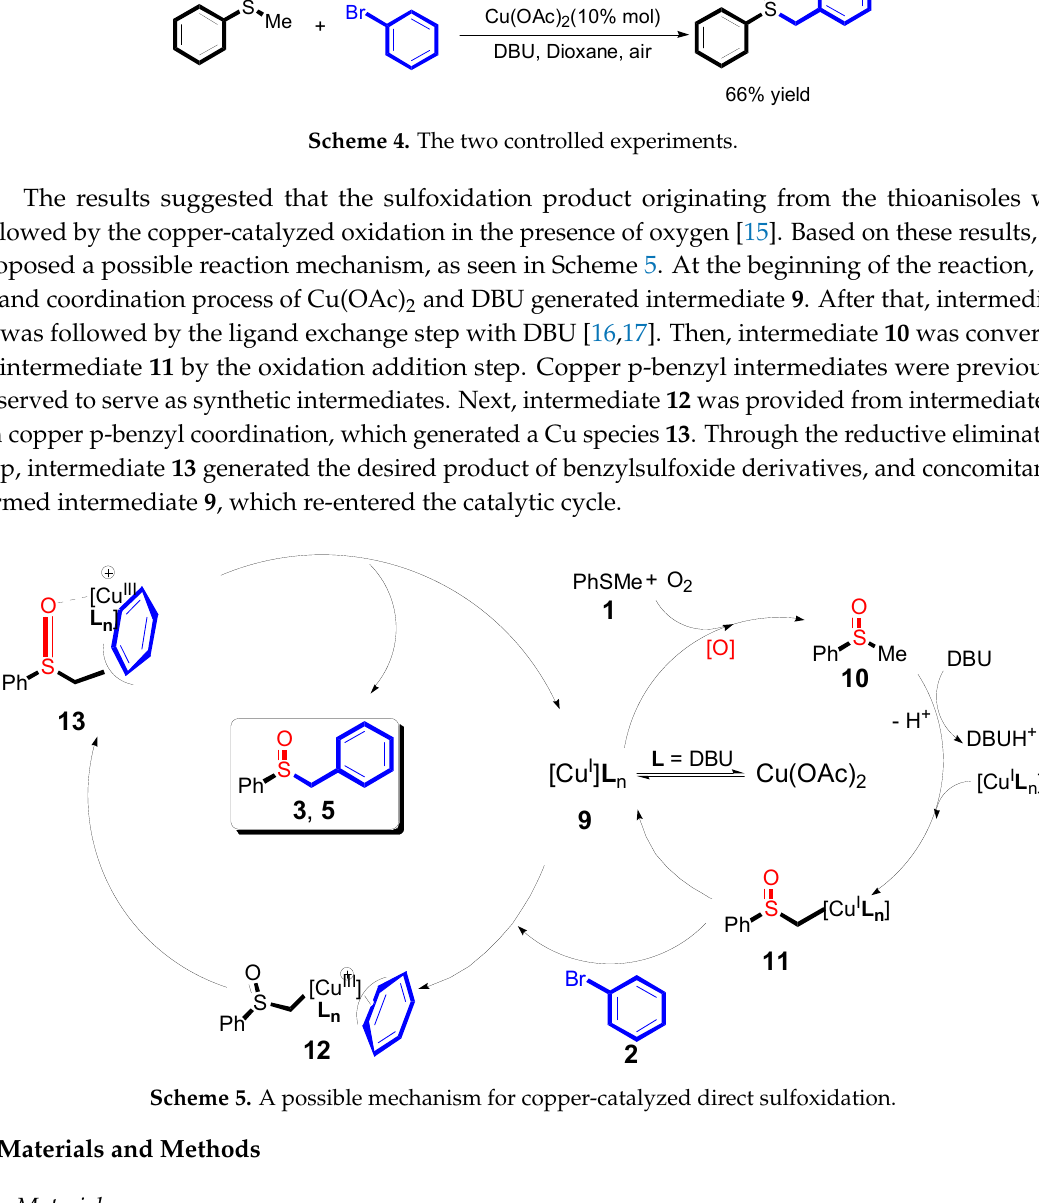
Scheme 5. A possible mechanism for copper-catalyzed direct